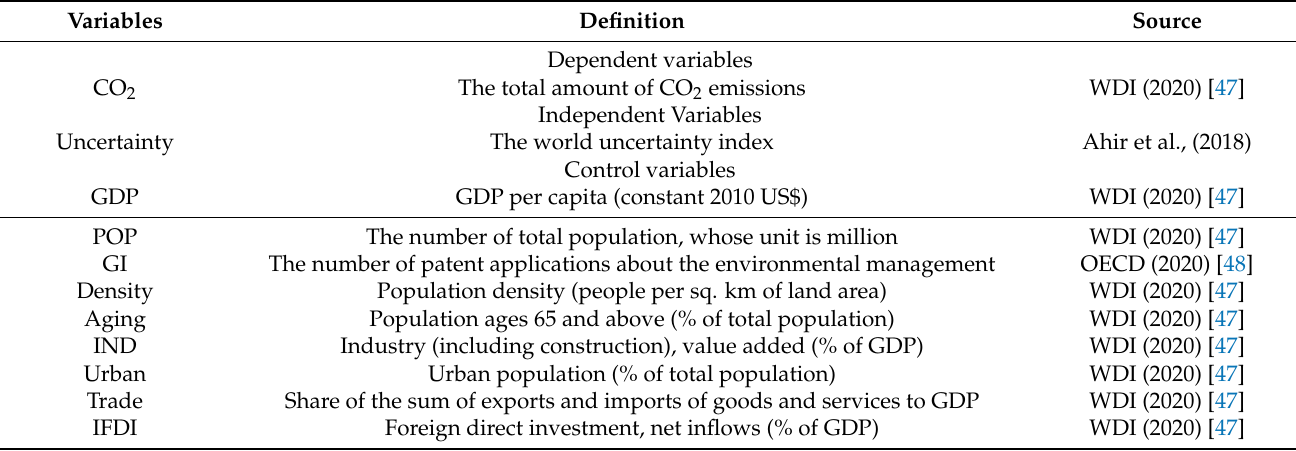
Table 1. Variable